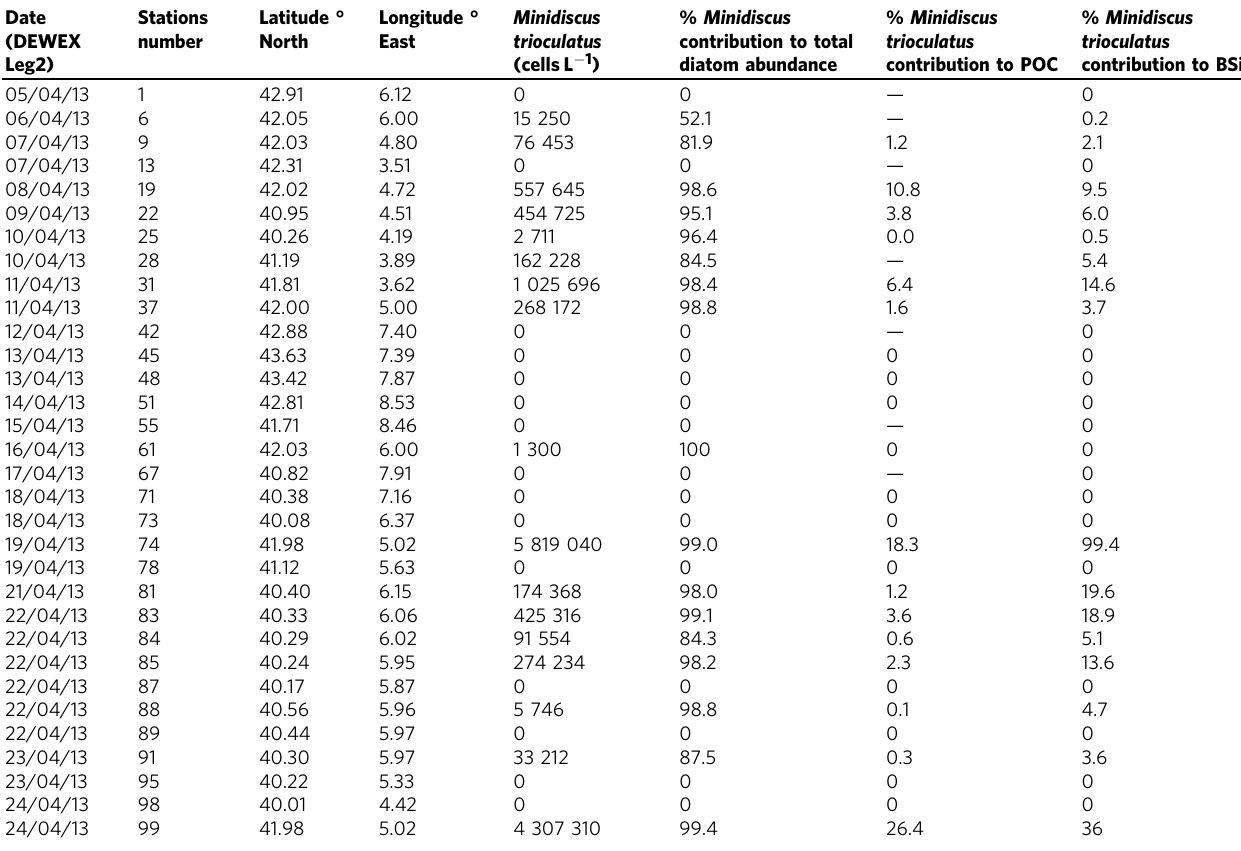
Table 1 Minidiscus spp. cell counts and relative contribution to abundance and